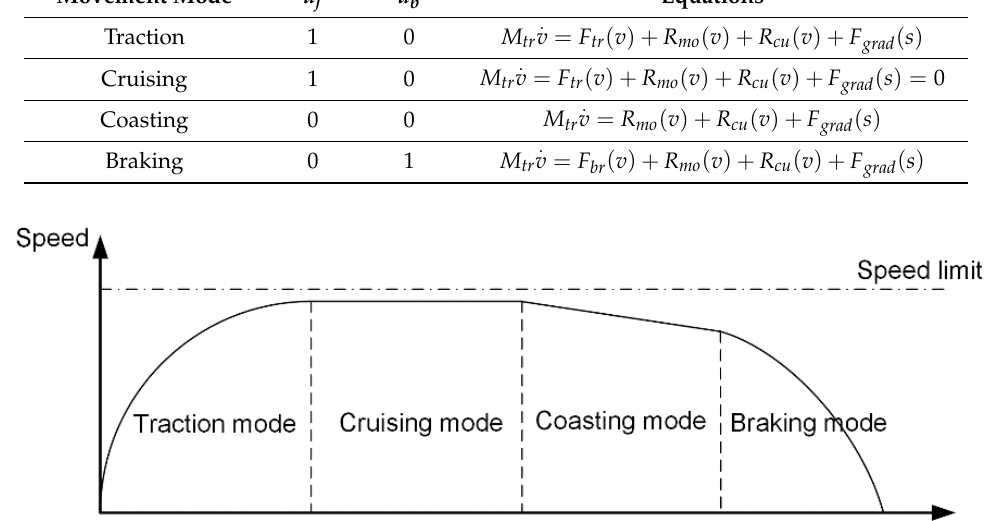
Table 1. Control signals in the four movement modes.